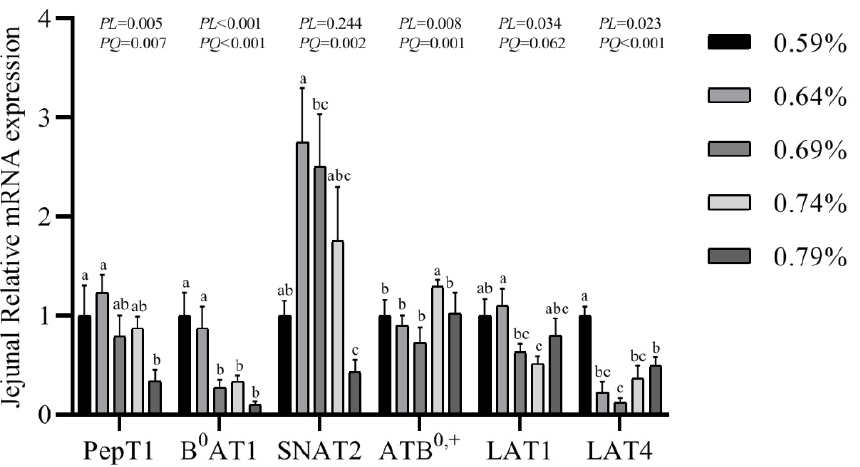
Figure 4. Effects of dietary valine levels on mRNA expression levels of PepT1, B 0 AT1, SNAT2, ATB 0,+ , LAT1, and LAT4 in jejunum of laying hens. Values are represented as the mean and SEM (n = 6–8). Means with different superscript letters (a–c) within a column differ significantly ( p < 0.05).